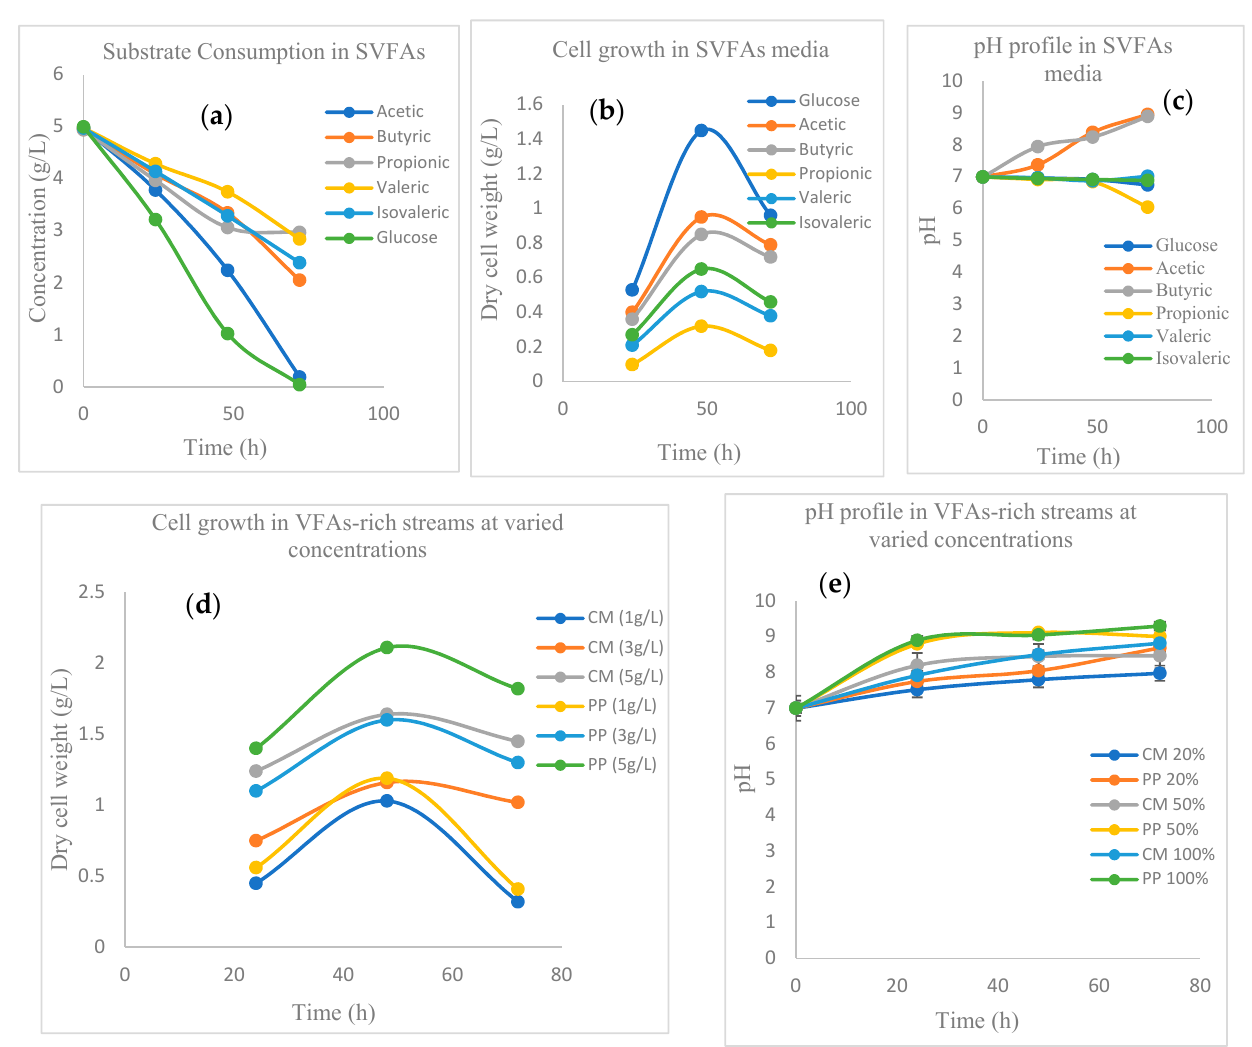
Figure 1. ( a ) Substrate consumption, ( b ) cell growth, and ( c ) pH profile in synthetic volatile fatty acids (SVFAs) media; ( d ) cell growth and ( e ) pH profile in volatile fatty acids rich (VFAs-rich) media during Pseudomonas oleovorans cultivation. Table 1. Dry cell weight and PHAs accumulation by P. oleovorans in synthetic VFAs media.